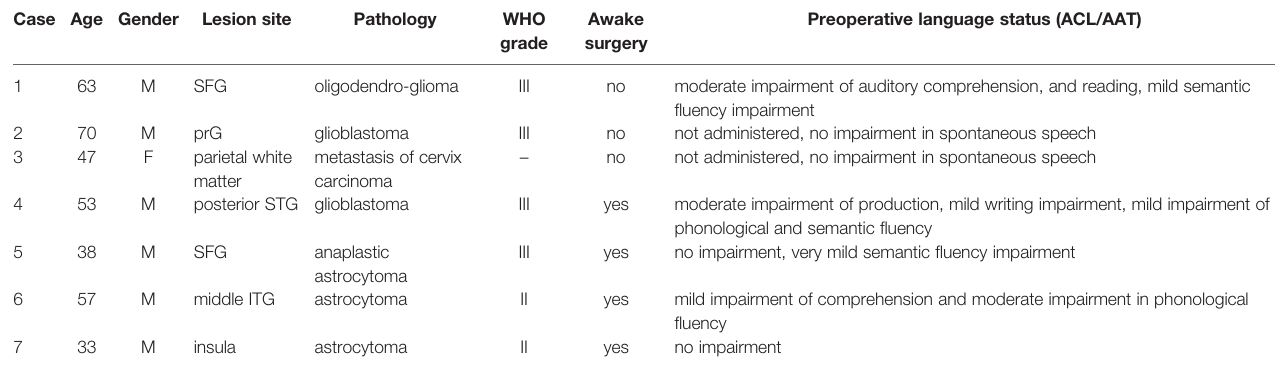
TABLE 1 | Demographics of the patient